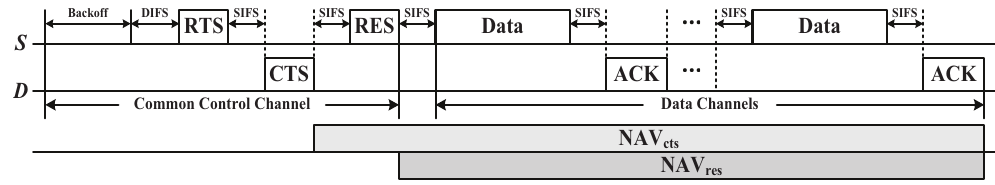
Figure 6. CAD-MAC transmission process.